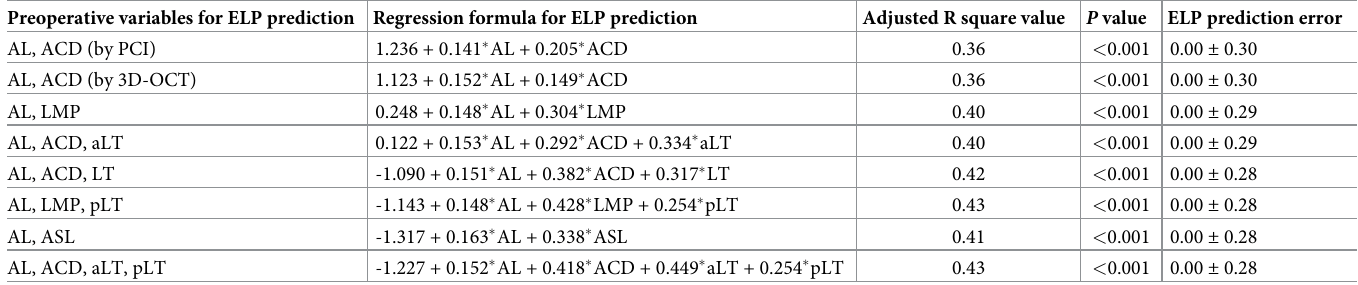
Table 4. Regression formulas for effective lens position (ELP) prediction and ELP prediction error from each combination from training set (n = 92). Preoperative variables for ELP prediction Regression formula for ELP prediction